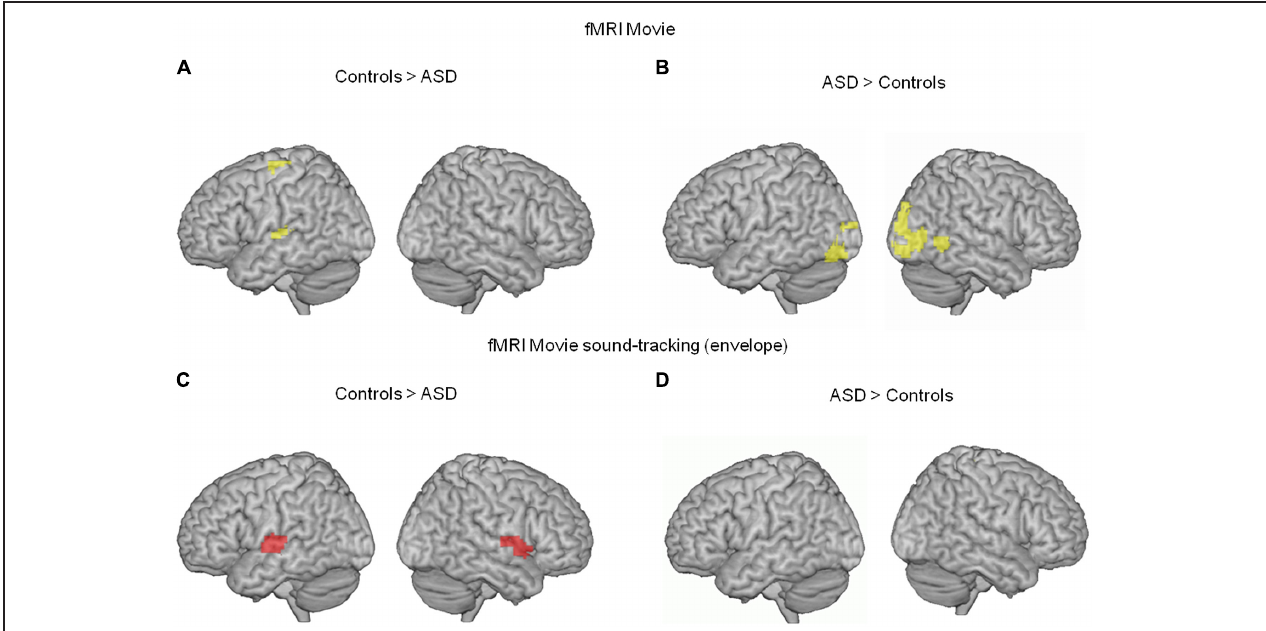
FIGURE 1 | (A,B) Comparison of neural activity blood oxygen-level dependent (BOLD) in 13 subjects with autism and 13 unaffected controls, when they were watching a scientific TV program (vs. rest). In autism, neural activity was reduced in the left supplementary motor area and left auditory cortex (whole brain interaction p < 0.02, uncorrected; Heschl’s gyrus, p = 0.02 FWE corrected; 54, − 19, 7 MNI coordinates), and enhanced in bilateral visual cortex (whole